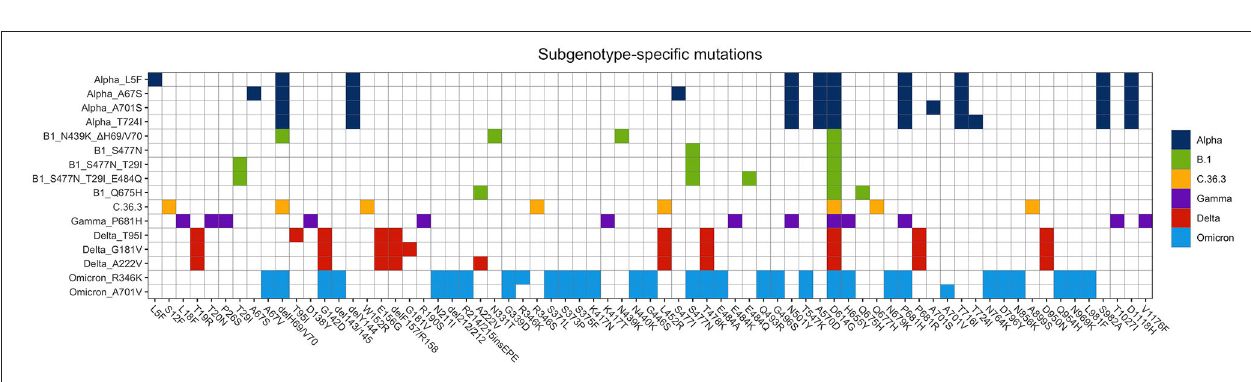
July 2021, the dominant VOCs were Alpha and Delta (46